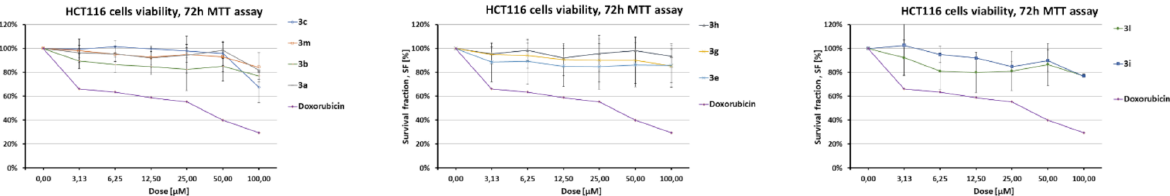
Figure 3. SF of HCT116 cells after 72 h of incubation with different doses of the tested compounds (0–100 µ M) and doxorubicin as a positive control. The results were presented as the mean values from 3 experiments ±